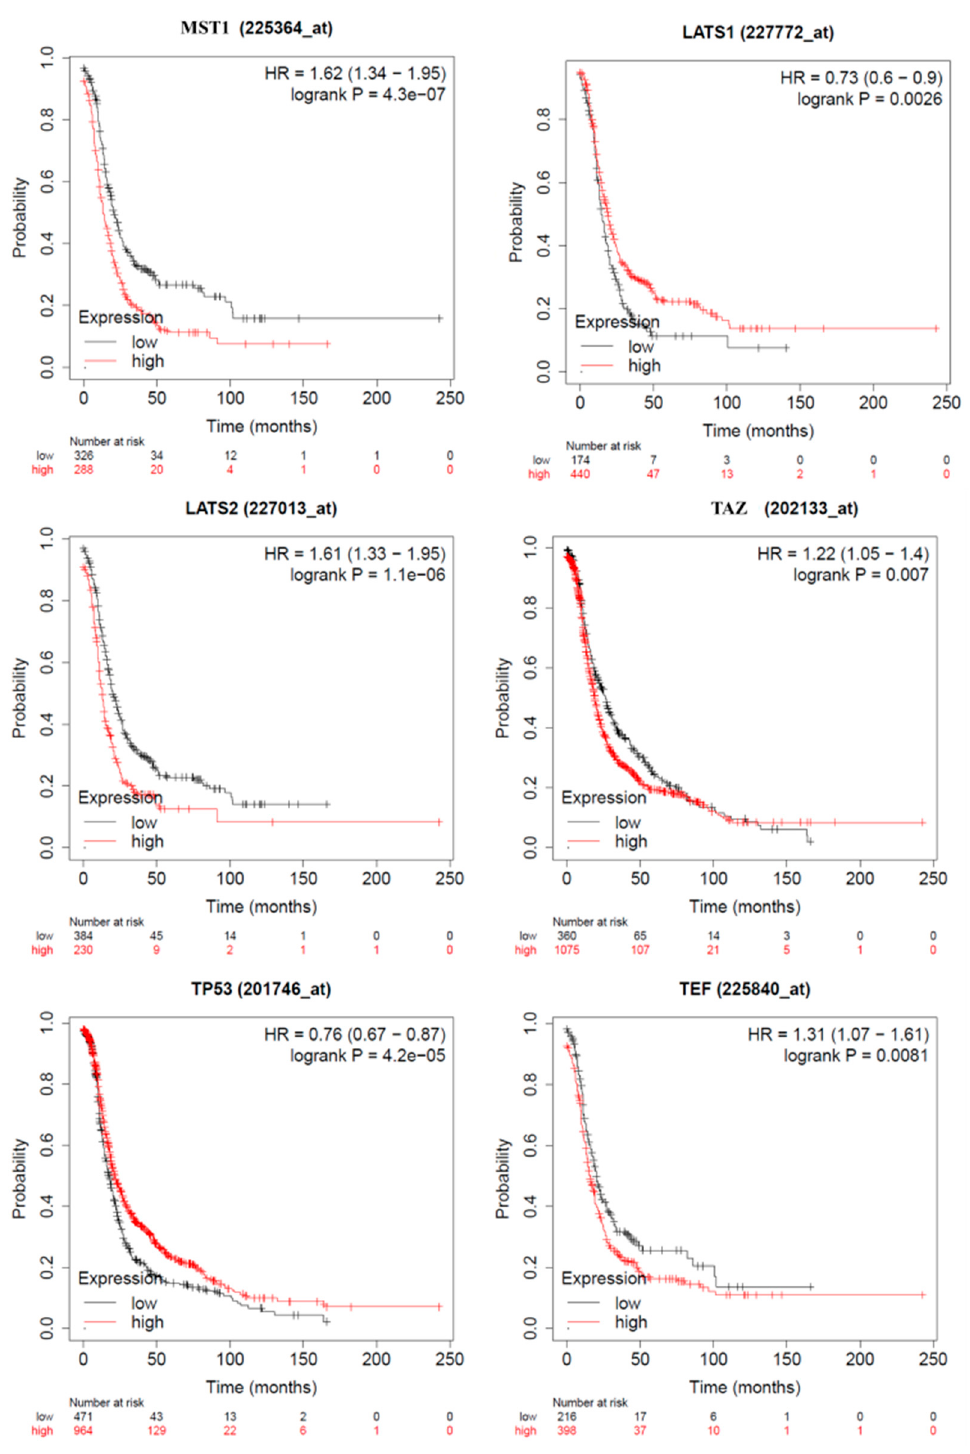
Figure 2. Progression-free survival (PFS) of key Hippo signaling genes for OC patients, according to high or low expression level. n = 1435 OC patients according to the expression of the Kaplan–Meier plotter (https://kmplot.com/analysis/index.php?p=service, accessed on 4 January 2021) based on TCGA patients, a log-rank test was used (MST1 high/low, p = 0.1; LATS1 high/ low p = 0.0026; LATS2 low/high p = 1.1 × 10 − 6 ; TAZ low/high, p = 0.007; TEF high/low, p = 0.0081; TP53 high/low, p = 4.2 × 10 − 5 ).